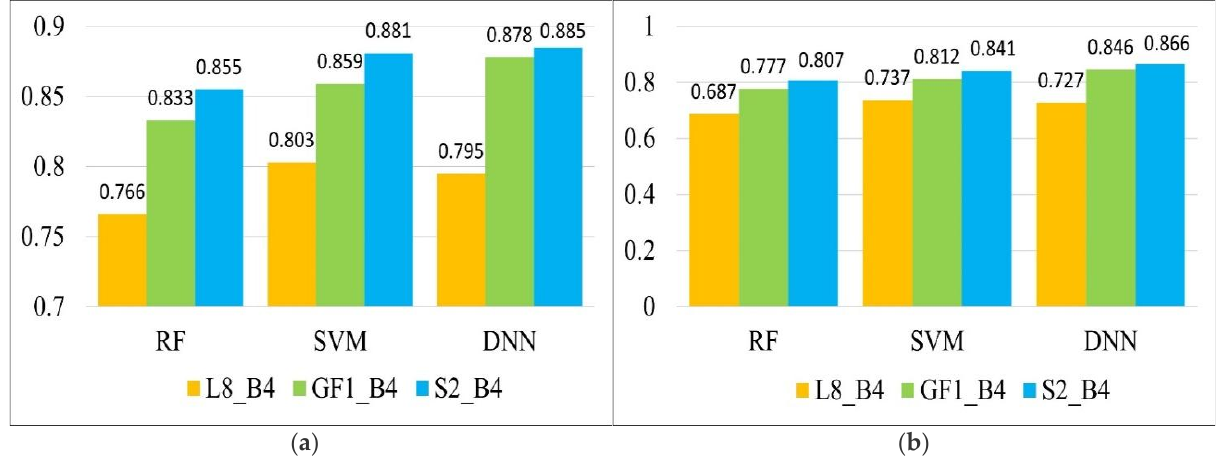
Figure 6. ( a ) Overall accuracy of different B4 models; ( b ) kappa coefficient of different B4 models.